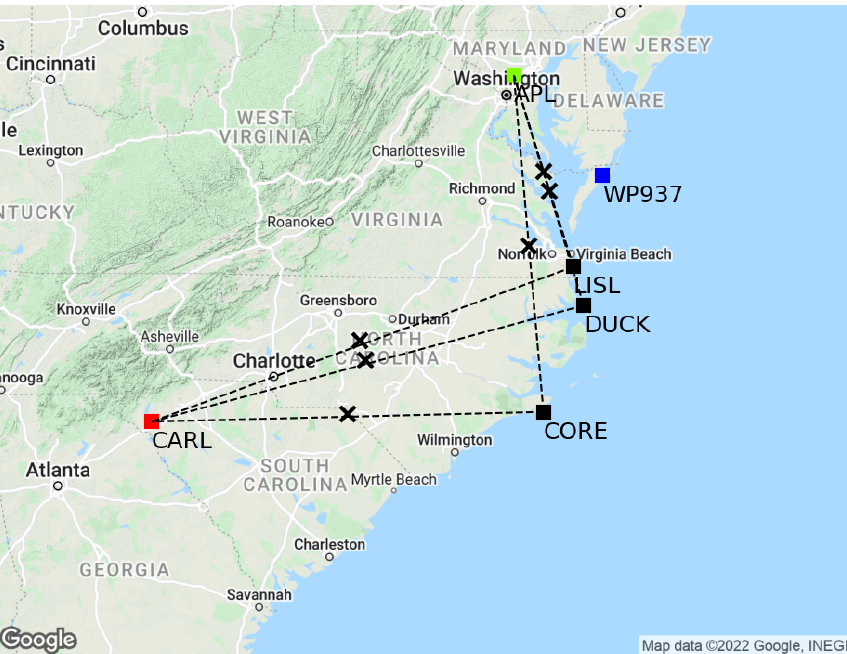
Figure 1. A map showing the physical locations of the CODAR transmitters (DUCK, CORE, and LISL), the Wallops Island digisonde (WP937), and the receive locations of MSR and CARL. Midpoint locations along the great circle path are shown as black X marks. Table 2. Receiver and transmitter sites. Site Function